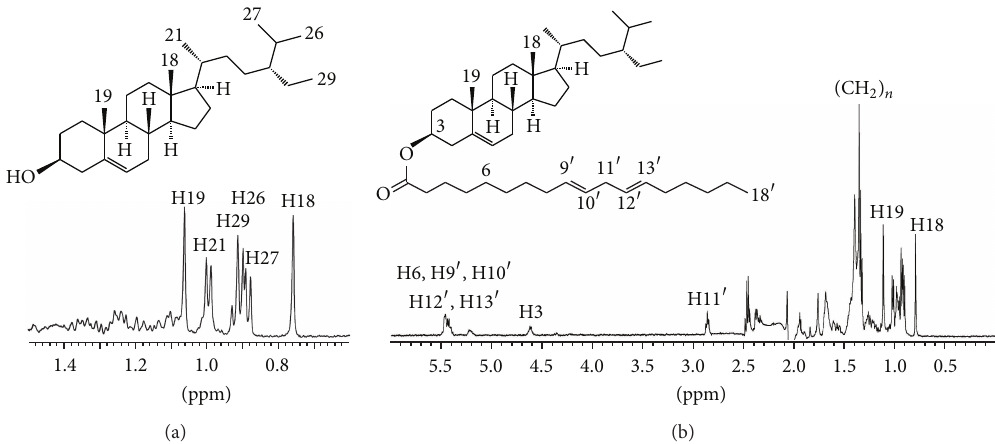
Figure 1: 1 H NMR spectra of free (a) and conjugated (b) 𝛽 -sitosterols. Spectra were collected in a stop-flow LC-NMR